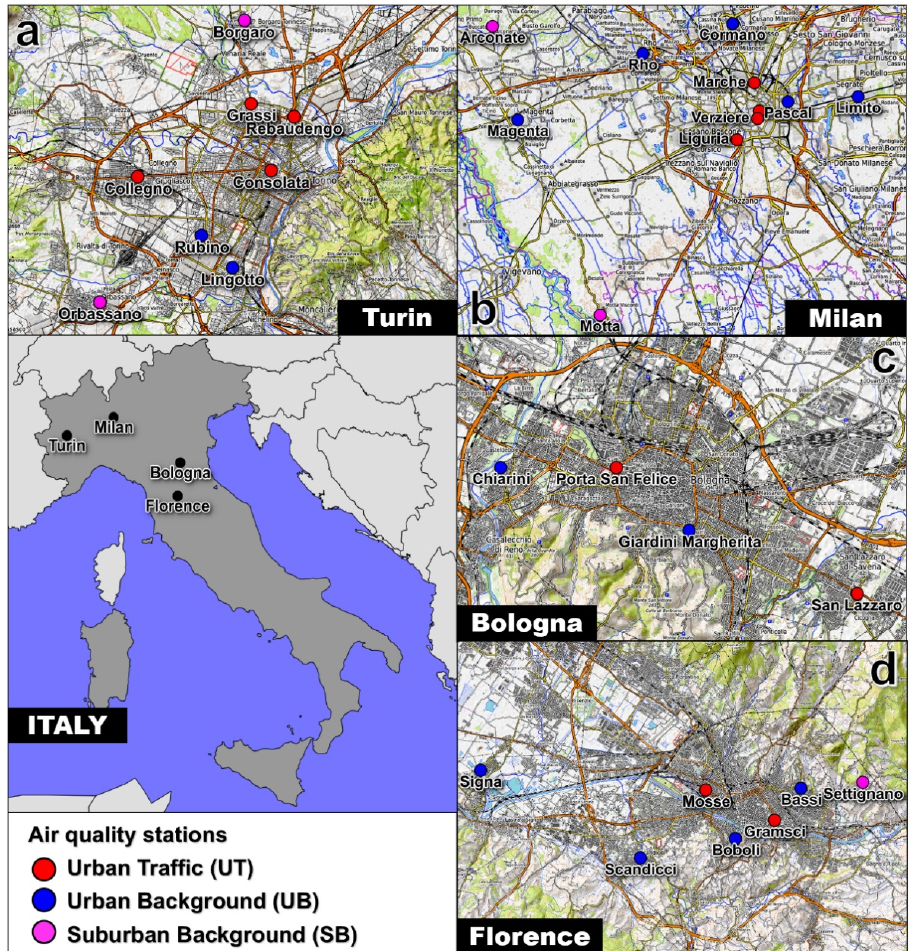
Figure 1. Map of the urban study areas in Italy, also showing location of urban traffic (UT), urban background (UB), and suburban background (SB) air quality stations: ( a ) Turin; ( b ) Milan; ( c ) Bologna; ( d ) Florence. Cartography basemap: OpenTopoMap.